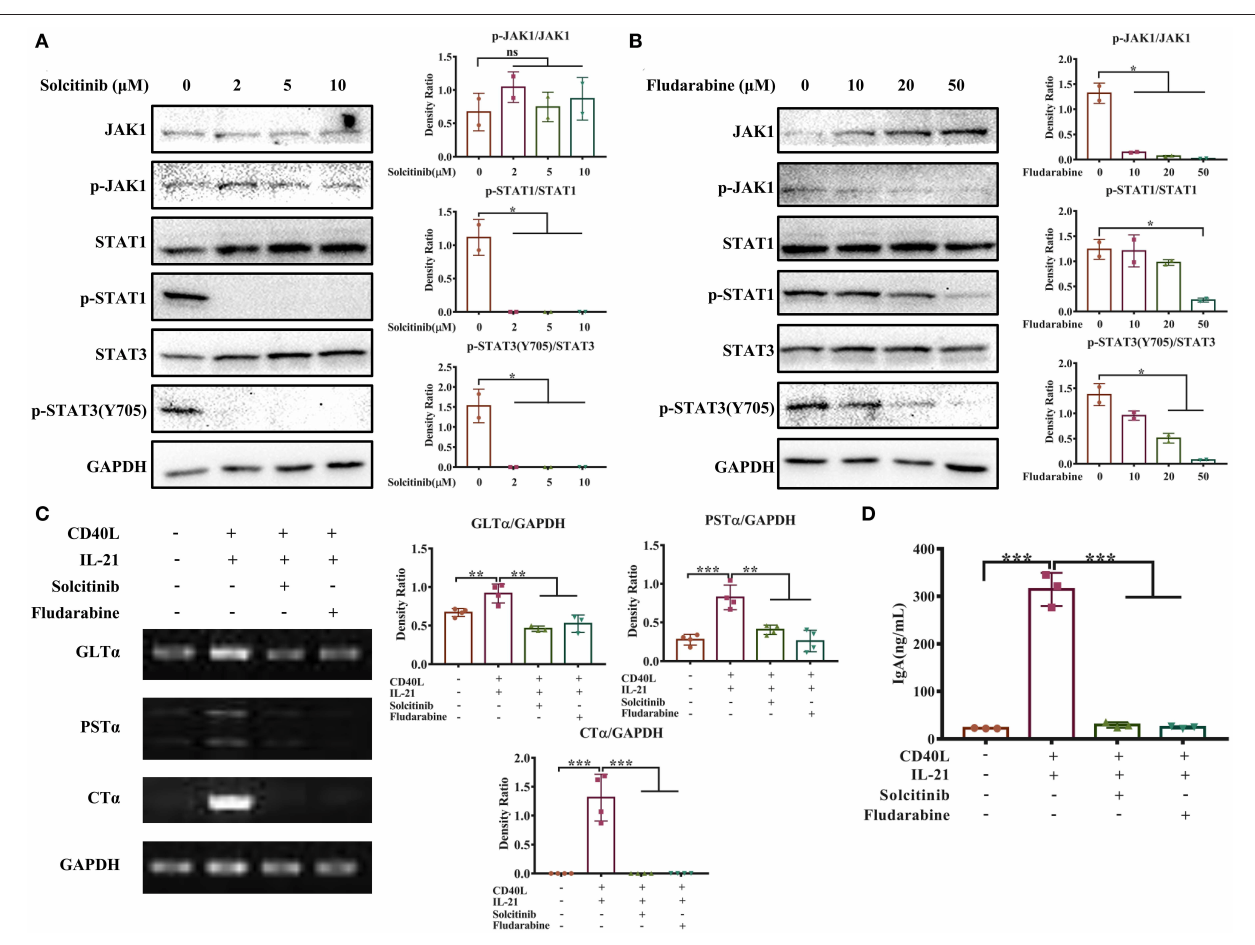
FIGURE 6 | The JAK-STAT signaling pathway is involved in IL-21-induced IgA CSR. IgM + B cells from porcine Peyer’s patches were cultured with different concentrations of solcitinib (A) or fludarabine (B) for 24h and then stimulated with CD40L + IL21 for 2h. The total and phosphorylated amounts of JAK1, STAT1, and STAT3 proteins were assessed by western blotting, and their density ratio was also analyzed and shown. IgM + B cells were treated with 2 µ M solcitinib or 50 µ M fludarabine for 24h and were then cultured with CD40L + IL-21 for 5 days. The cells were then collected at 60h post-treatment and subjected to semi-quantitative PCR to assess the expression levels of GLT α , PST α , and CT α (C) , while cell supernatants were collected, and IgA levels were detected by ELISA (D) . All experiments were performed independently in duplicate or triplicate. * p ≤ 0.05; ** p ≤ 0.01; *** p ≤